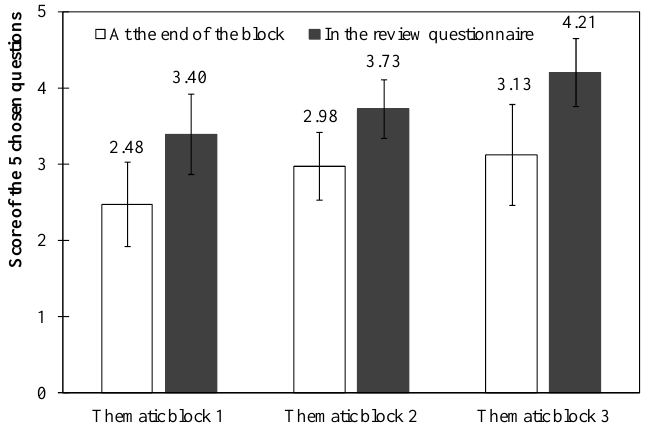
Fig. 2. Averages and standard deviation of the scores obtained in the five chosen questions corresponding to the three thematic blocks, in the questionnaire carried out at the end of the block and in the review